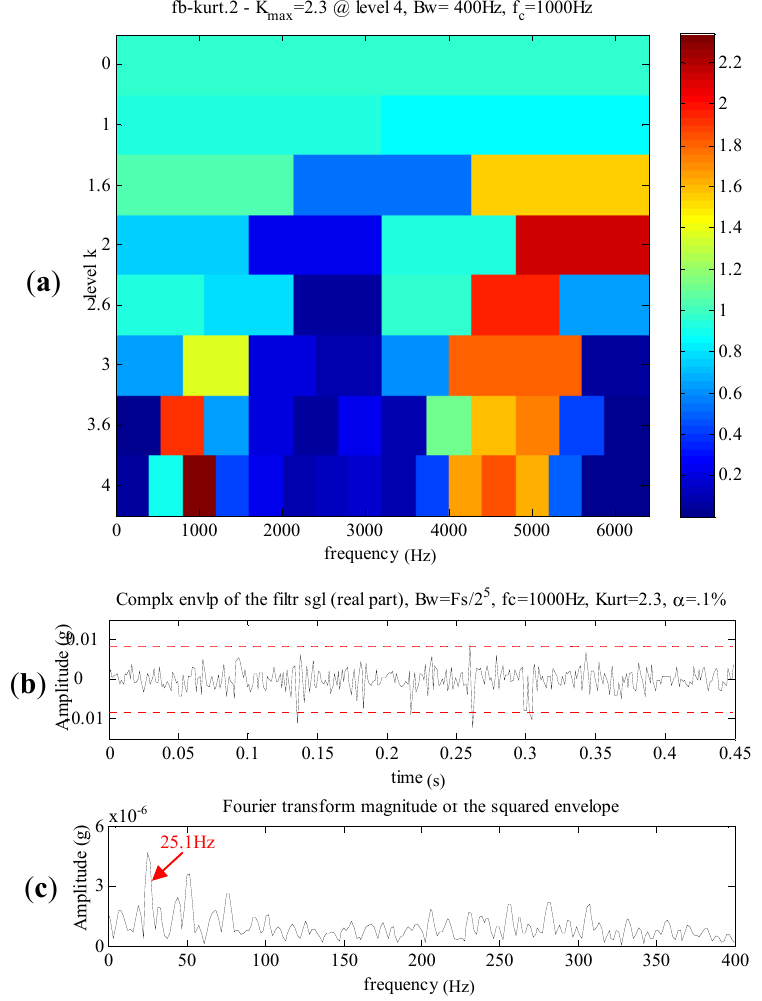
Figure 13. The analyzed results of the normal planetary gearbox signal using spectral kurtosis. ( a ) The Kurtogram. ( b ) The purified signal. ( c ) The envelope spectrum (low-frequency